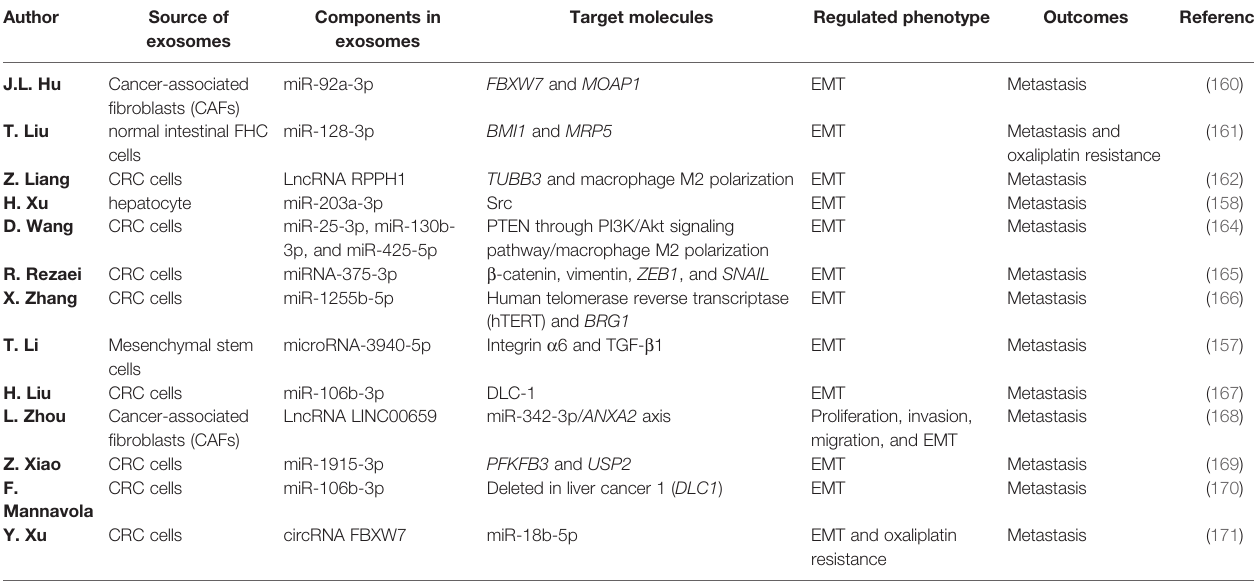
TABLE 3 | Functions of exosomes in colorectal cancer (CRC) metastasis via regulating the epithelial – mesenchymal transition (EMT)